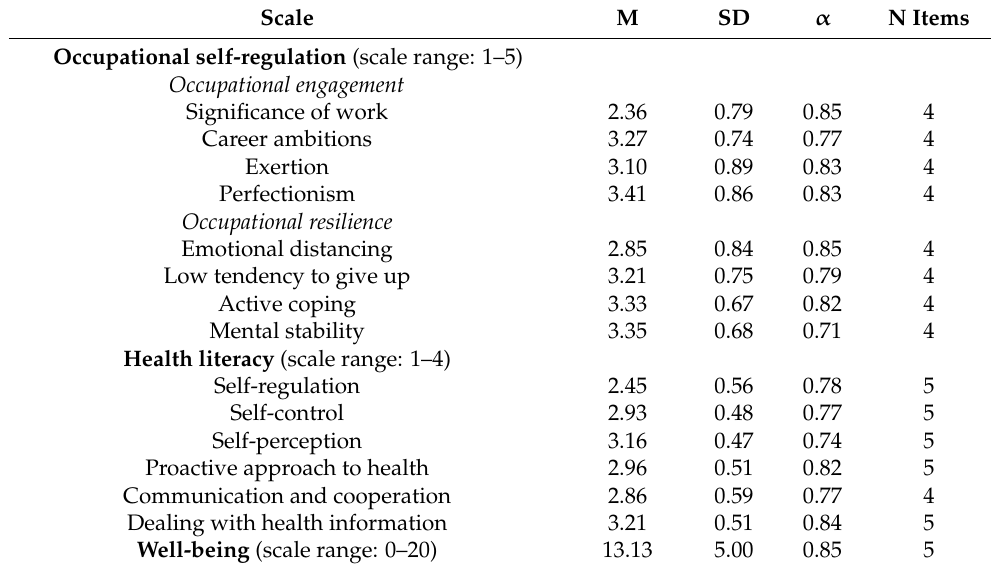
Well-being (scale range: 0–20)